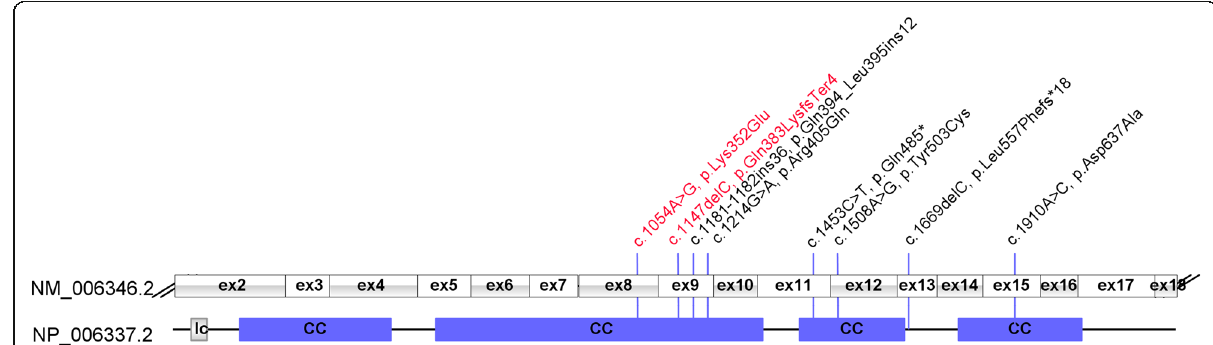
Fig. 3 Pathogenic variants in the PIBF1 gene and the protein structure. The novel variants of this study are marked in red. CC, coiled coil region; lc, low complexity